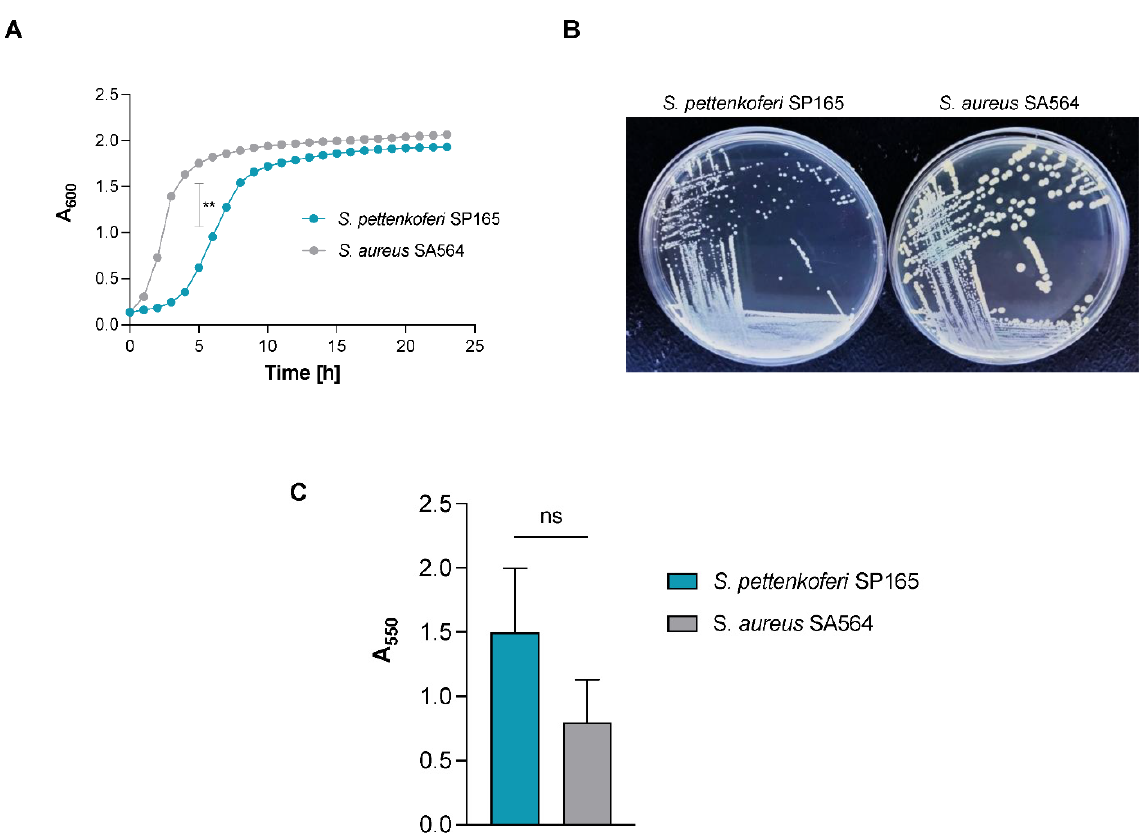
Figure 1. Growth of S. pettenkoferi SP165. ( A ) Growth kinetics of S. pettenkoferi SP165 (blue circles) and S. aureus SA564 (grey circles) strains in TSB. At a culture to flask volume of 1:10, cells were grown at 37 °C and 225 rpm. At each time point ( n = 3), the data show the mean A 600 readings SD. Welsh’s t test, **, p < 0.01. ( B ) Growth of S. pettenkoferi SP165 (left panel) compared with S. aureus SA564 (right panel) phenotype on TSB agar plate grown at 37 °C for 48 h. ( C ) Kinetics of the complete biofilm formation determined by crystal violet experiment. The optical density (500 nm) is directly linked to the biofilm formation. Means and standard errors for six independent replicates are presented. Statistical differences were obtained by Mann–Whitney; ns, not significant.